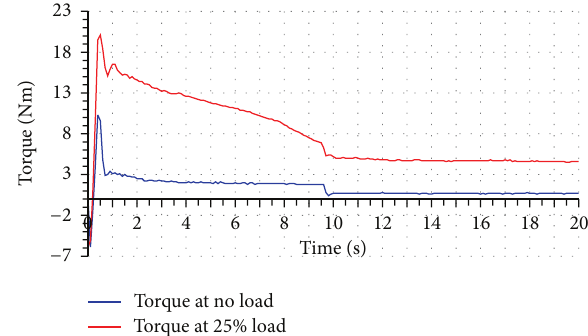
Figure 9: Torque variation of IM drive during starting at different loads and 1440rpm